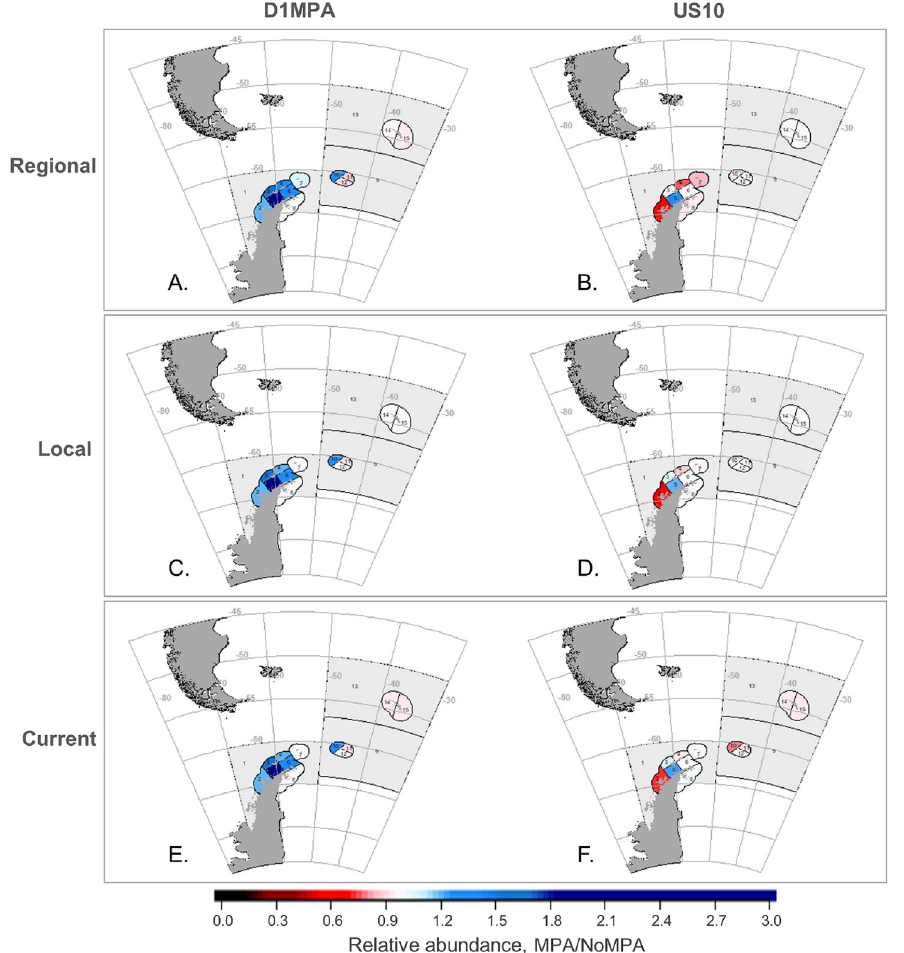
Fig 4. Outcomes for penguins by SSMU in both MPA scenarios. Changes in penguin abundance with an MPA relative to the No MPA reference (i.e. MPA/No MPA), with the top row (A and B) the Regional redistribution of displaced catches, the middle row (C, D) the Local alternative, and bottom row (E, F) the Current alternative. The left column illustrates results from the D1MPA scenario (A, C, E) and the right from US10 (B, D, F). Grey indicates areas where the species group is not modeled to recruit. Note that changes are relative to the no MPA scenario within each SSMU, not to overall